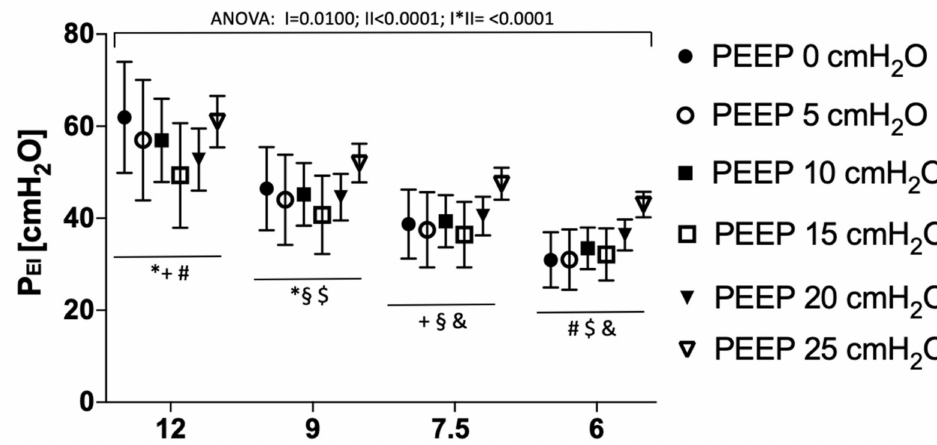
Figure 4. End-inspiratory pressure (P EI ) resulting from a slow inflation with tidal volumes of 12, 9, 7.5, and 6 mL / kg at PEEP levels of 0, 5, 10, 15, 20, and 25 cmH 2 O. Repeated measures ANOVA: I: